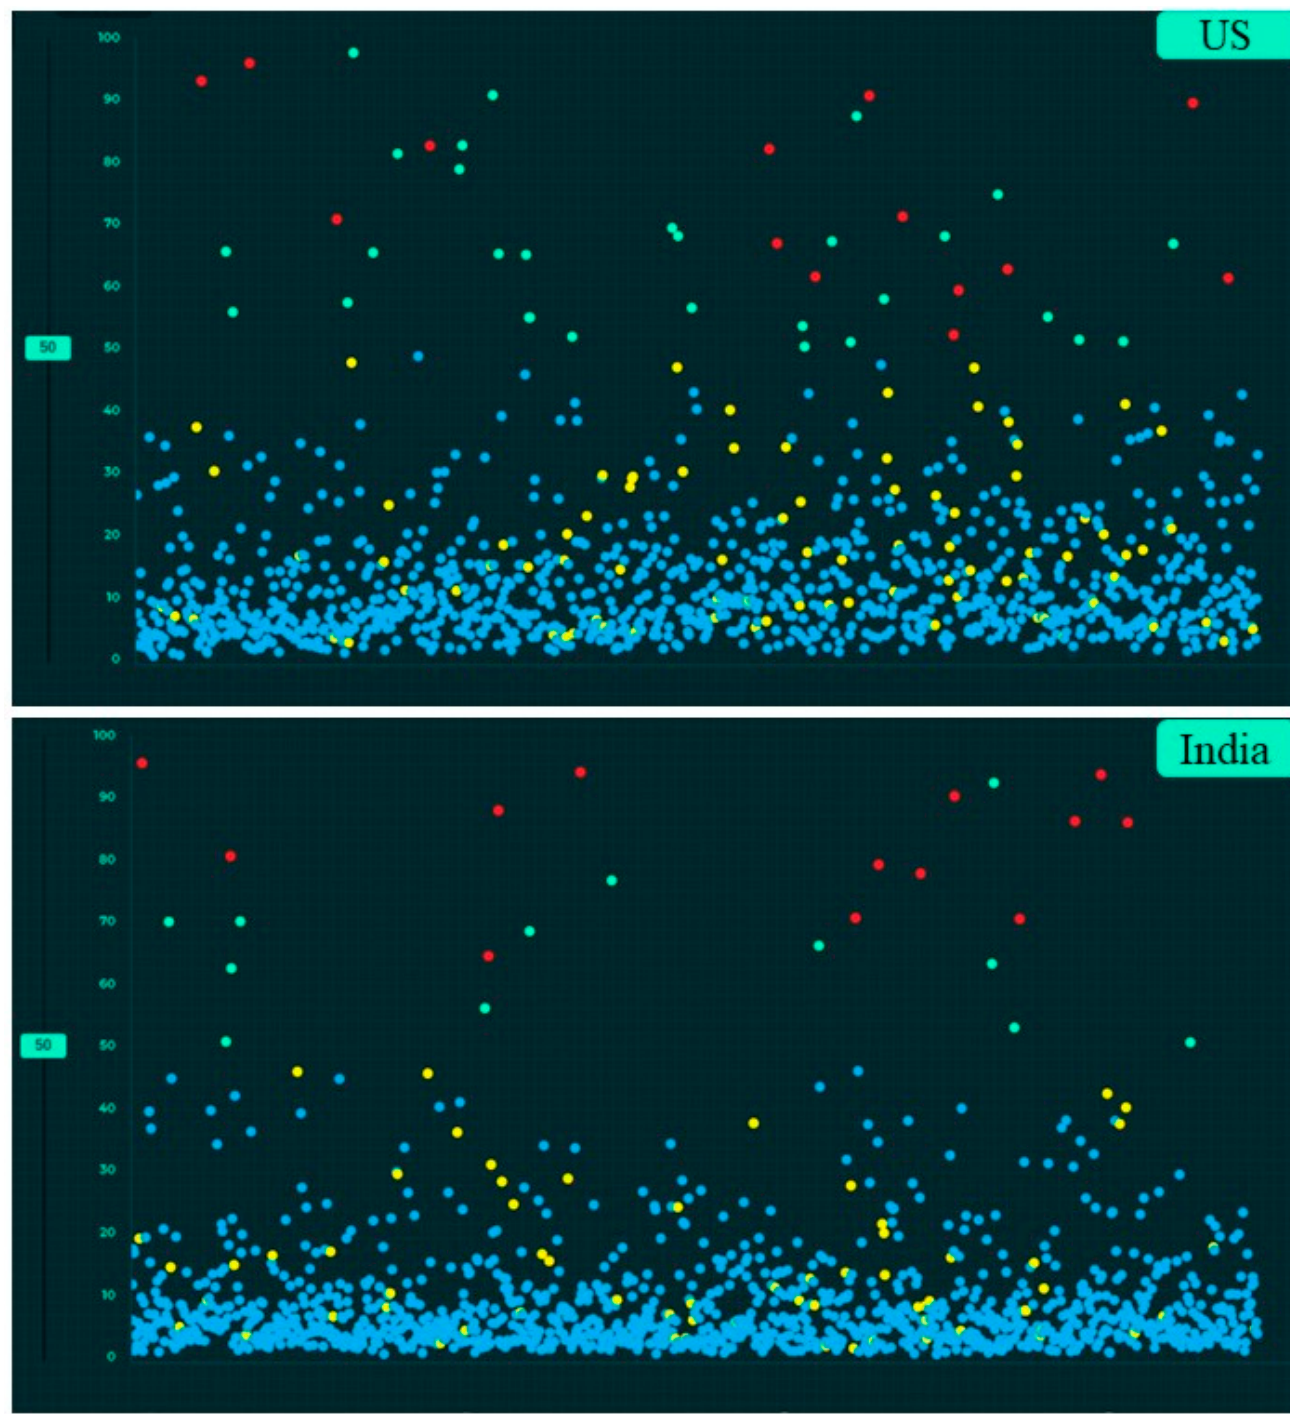
Figure 5. Screen captures of the AI validation platform displaying scatterplots of AI-detected and undetected CXR findings based on country (true positive (red dots), true negative (blue dots), false negative (yellow dots) and false positive (green dots)).